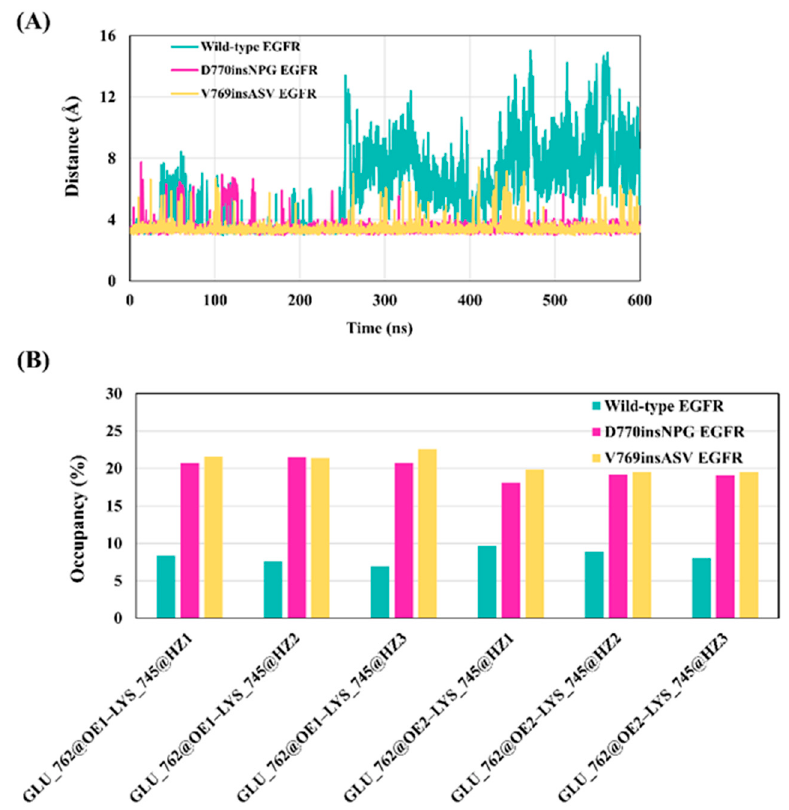
Figure 7. Distance and hydrogen bond occupancy between Lys745 and Glu762 during the wild-type and insertion mutants MDS. ( A ) Distance between the N ζ atoms of Lys745 and C δ atom of Glu762 during the wild-type and insertion mutant simulations. The mutants preserved a shorter and less variable distance as compared to wild-type EGFR that exhibits a larger distance that implies that the salt bridge is broken. ( B ) The frequency of hydrogen bonds between the amine and carboxyl side-chain oxygen atoms of Lys745 and Glu762. The bonds were more frequently observed during the insertion mutant simulations than for the wild-type EGFR.